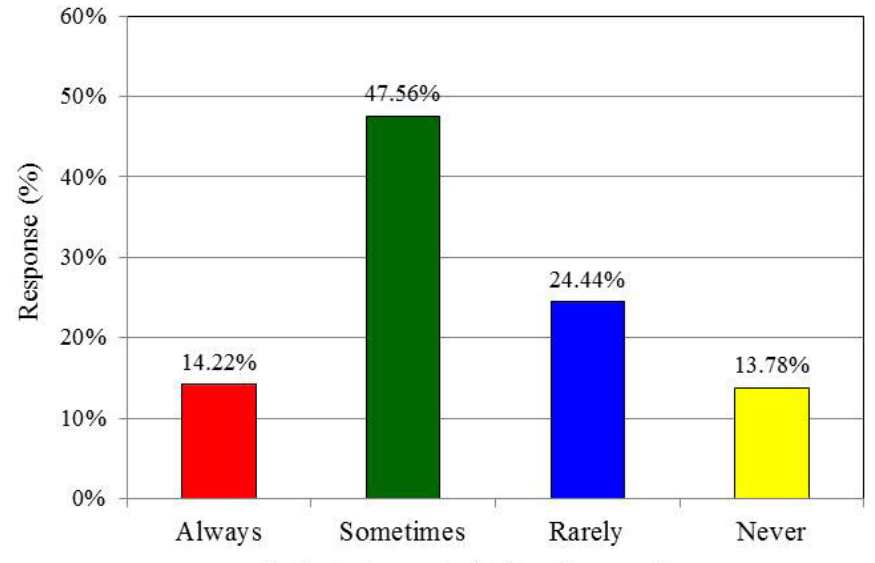
FIGURE 5 - Patient demands for brand-name drugs from hospital’